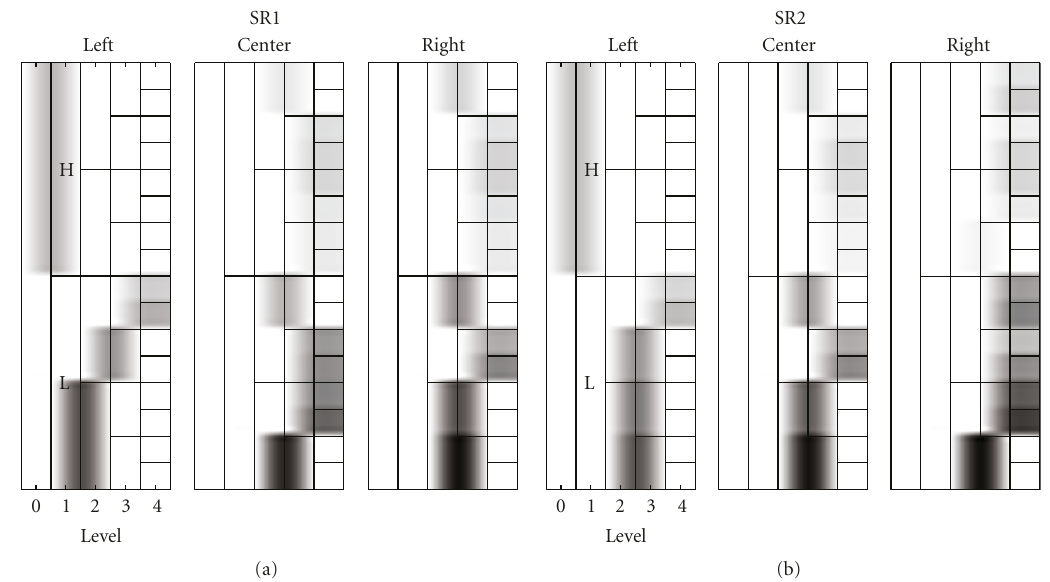
Figure 7: The WP subband tiling for datasets SR1 (a) and SR2 (b). Each selected subband is weighted with the corresponding log scaled Euclidean distance between classes. The darker nodes have higher discrimination